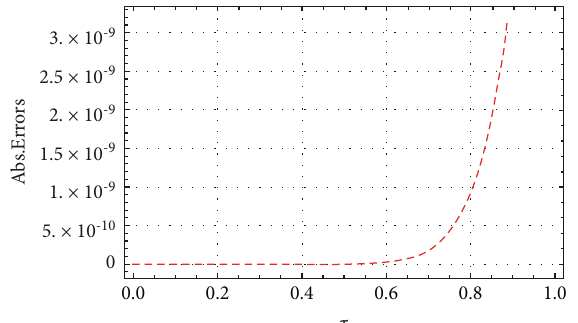
Figure 13: The absolute error for the real part of Example 3.